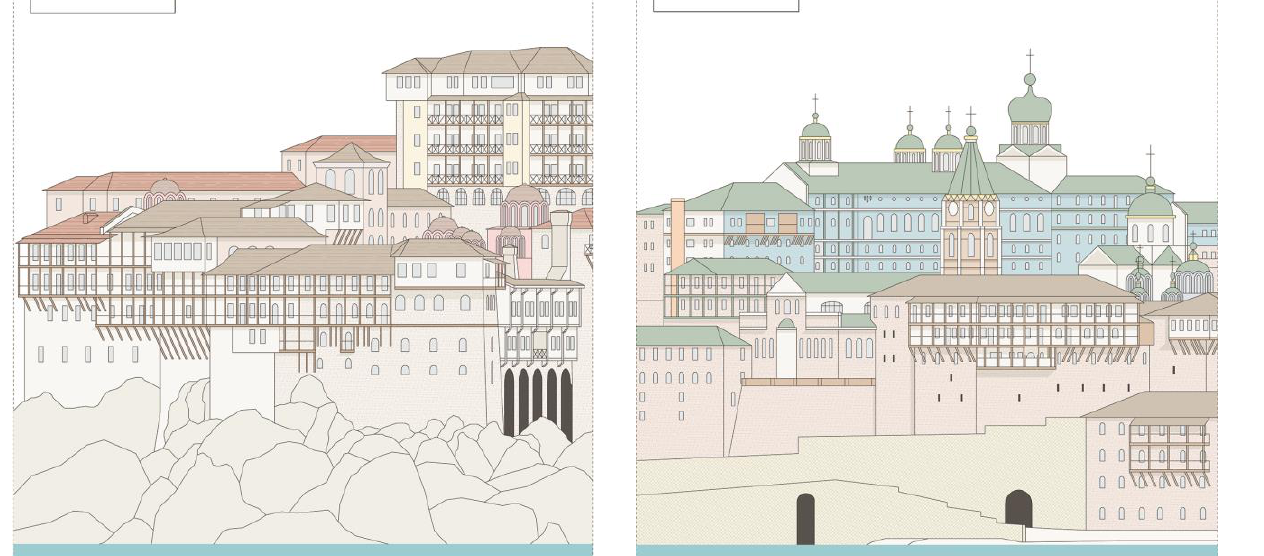
Figure 22 . The Monastery of St. Gregory. Detail of the western elevation.